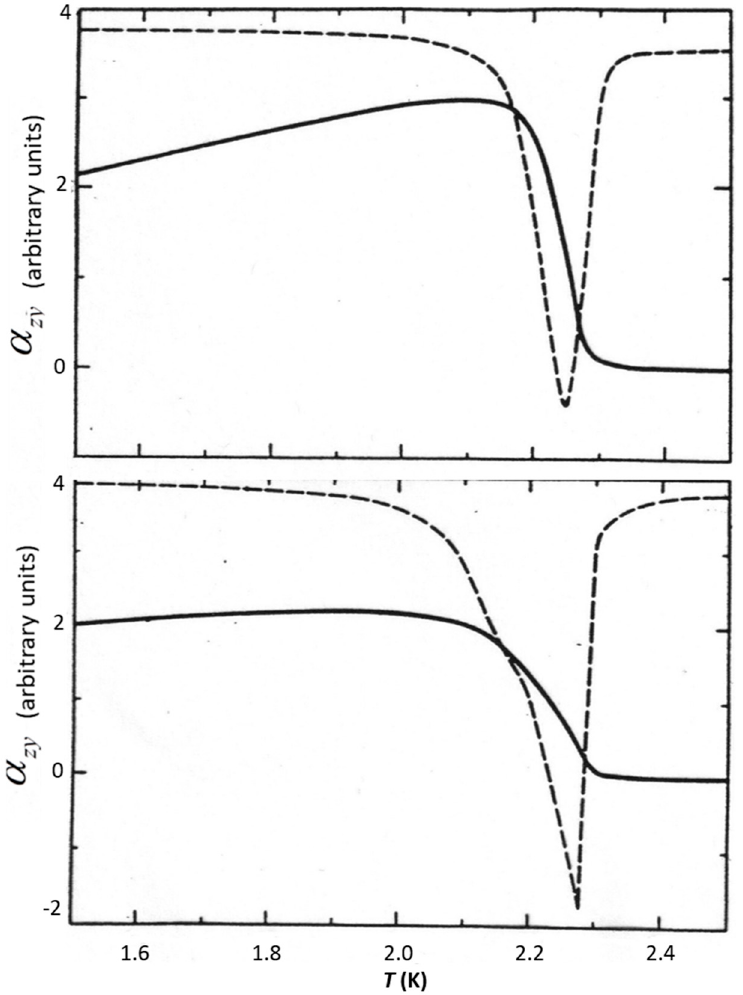
Figure 1. Magnetoelectric coefficient α zy (solid line) and its derivative (dashed line) dependence upon temperature T [15]: top—experimental; bottom—theoretical.